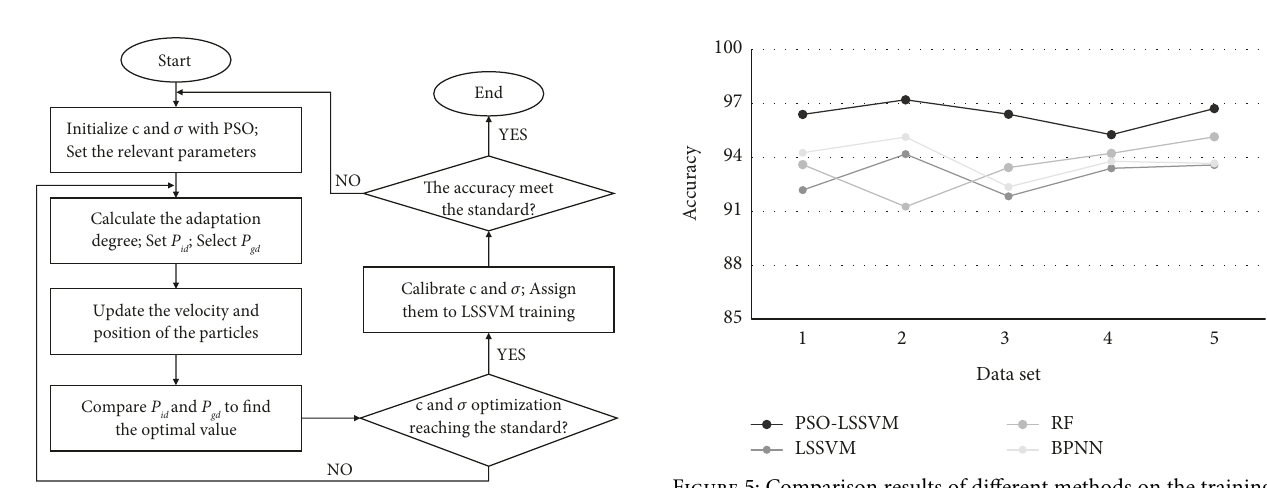
Figure 3: Flowchart of the Particle Swarm Optimization-Least Squares Support Vector Machine (PSO-LSSVM) evaluation method.